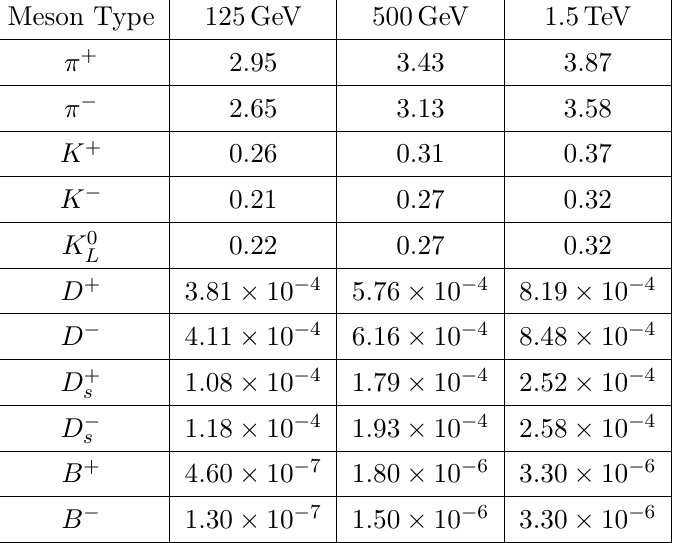
The number of mesons produced per generated Monte Carlo soft QCD event ( N ) at the three different beam energies. To obtain the number of mesons per EOT, we tot M, MC /N MC have to multiply these numbers by σ , as described in the text. Note that here we are SoftQCD /σ eN quoting the electron beam energy instead of the center-of-mass energy of the corresponding